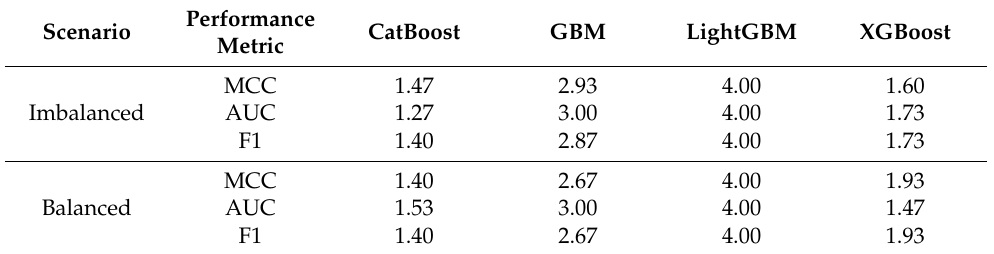
Table 2. Average Friedman rank of all algorithms across different performance